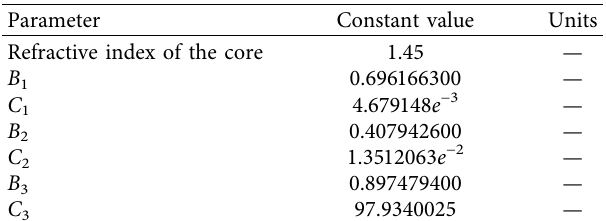
Figure 3: Finite element mesh generated from the PCF structures: (a) PCF with uniform air holes and without tiny air holes, (b) PCF with uniform air holes and insertion of 10 tiny air holes in the frst ring, and (c) PCF with nonuniform air holes and inclusion of 6 tiny air holes in the frst Table 1: Parameters and Sellmeier constants for silica used in designing all PCFs.